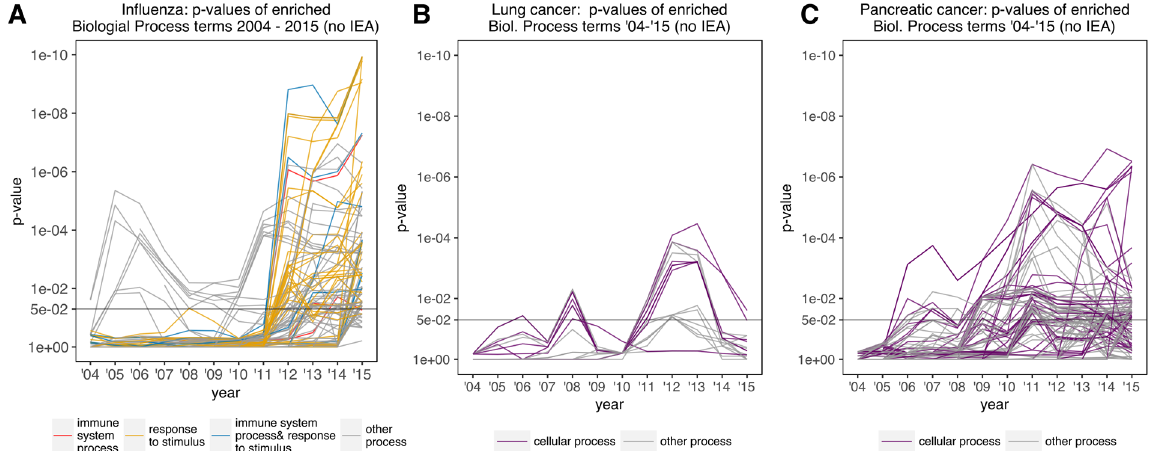
Figure 3. Significance of biological process GO terms over time with annual GO version updates (year of GO version = year of GO annotation version). Development of p-value significance in GO enrichment analysis result term sets in different GO versions are shown for subsets of significantly enriched biological process GO terms (p-value < 0.05 in at least one GO version) in three representative diseases: ( A ) influenza, ( B ) non-small cell lung cancer, and ( C ) pancreatic cancer. Terms belonging to selected top-level branches in the biological process ontology are indicated in color (e.g. cellular process in